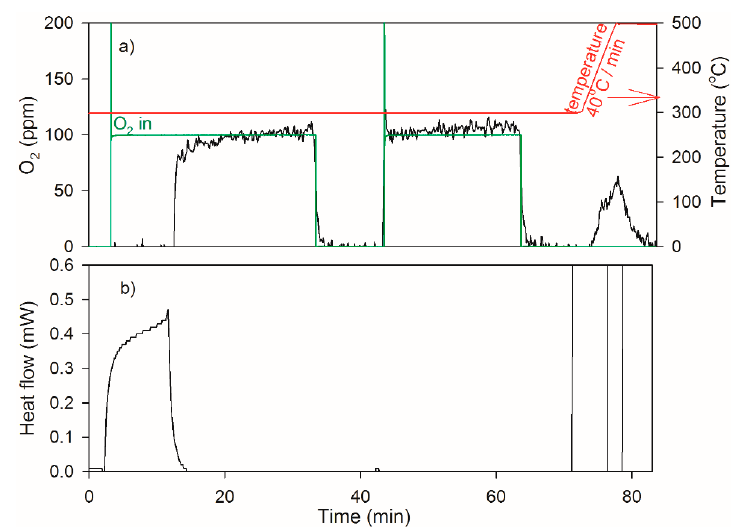
Figure 5. ( a ) Oxygen concentration and temperature as a function of the time and ( b ) the corresponding heat flow during O 2 TPD at 300 °C for 2 wt. % Pt/Al 2 O 3 . Experimental details are described in Section 3.